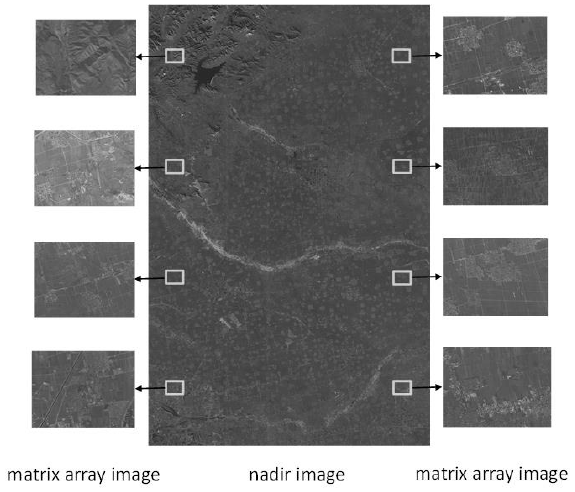
Figure 4. The nadir image and matrix array images